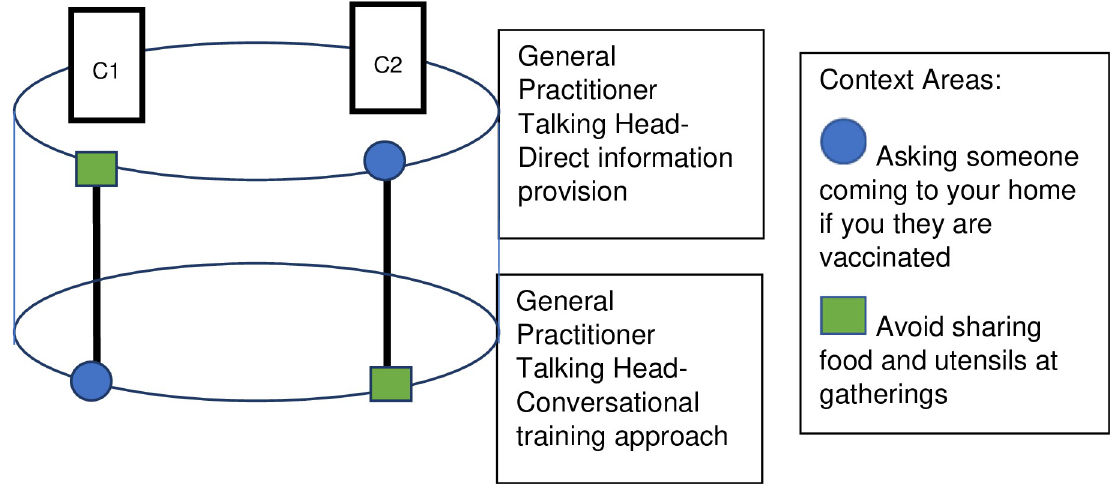
Fig 4. Visual representation of the helix randomised control trial design for Trial 3. C1 denotes combination 1, C2 denotes combination 2, Individual participants are exposed to the combinations of intervention level / context areas within a vertical combination column.